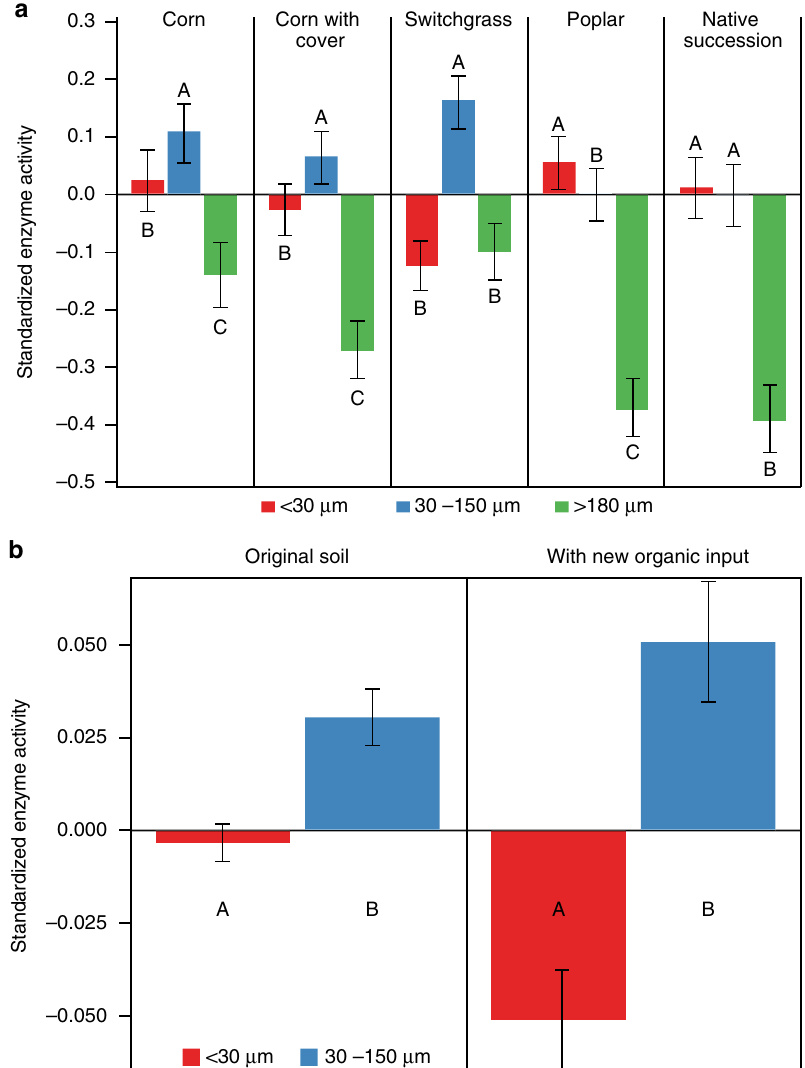
Fig. 4 Standardized enzyme activities in soil micro-sites with prevalence of pores of three size groups (<30 µ m, 30 – 150 µ m, and >180 µ m). a Enzyme activities from soil slices not subjected to incubations with fresh C inputs. Shown are means across all studied enzymes. Error bars are s.e.m. (based on 139 zymography layers from 13 soil cores). Letters within each cropping system mark statistically signi fi cant differences among pore size classes ( p < 0.05). b Enzyme activities from slices subjected and not subjected to incubations with fresh nutrient inputs; shown are means across all systems and enzymes. Error bars are s.e.m. (based on 88 and 14 zymography layers without and with new organic inputs, respectively, from 10 soil cores). Letters mark signi fi cant differences between enzyme activities in localities with <30 and 30 – 150 µ m pores ( p < 0.05). Summary data are provided as a Source Data fi le